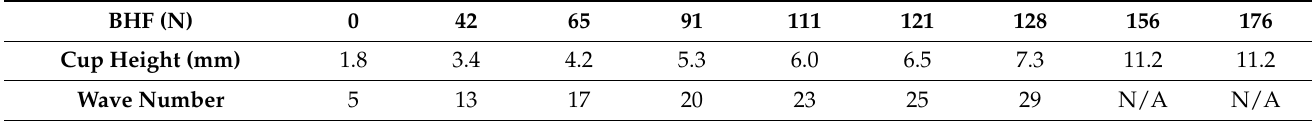
Table 1. Critical cup heights and wave numbers for cups drawn under different blankholding forces.